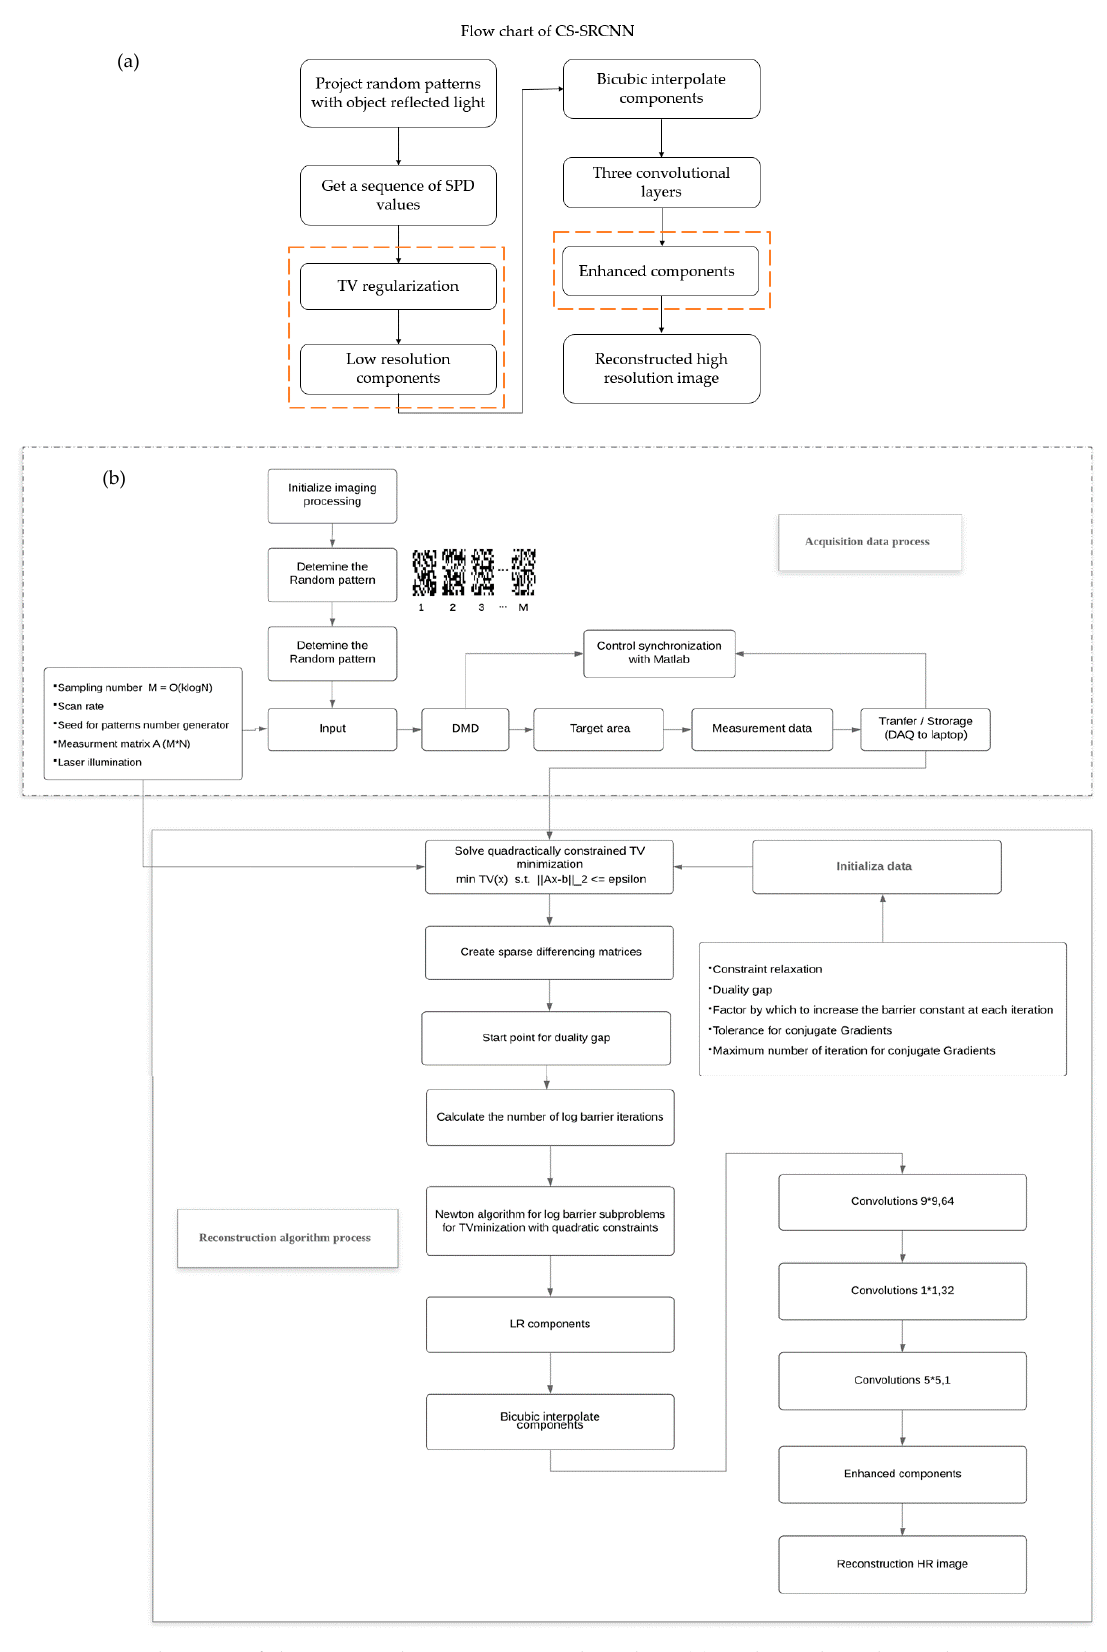
Figure 2. Activity diagram of the proposed reconstruction algorithm: ( a ) traditional single-pixel imaging and super-resolution convolutional neural network (SRCNN), and ( b ) the proposed method in this paper.